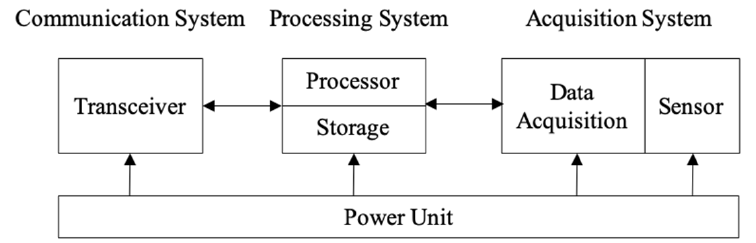
Figure 7. Schematic diagram of the wireless sensor [92].